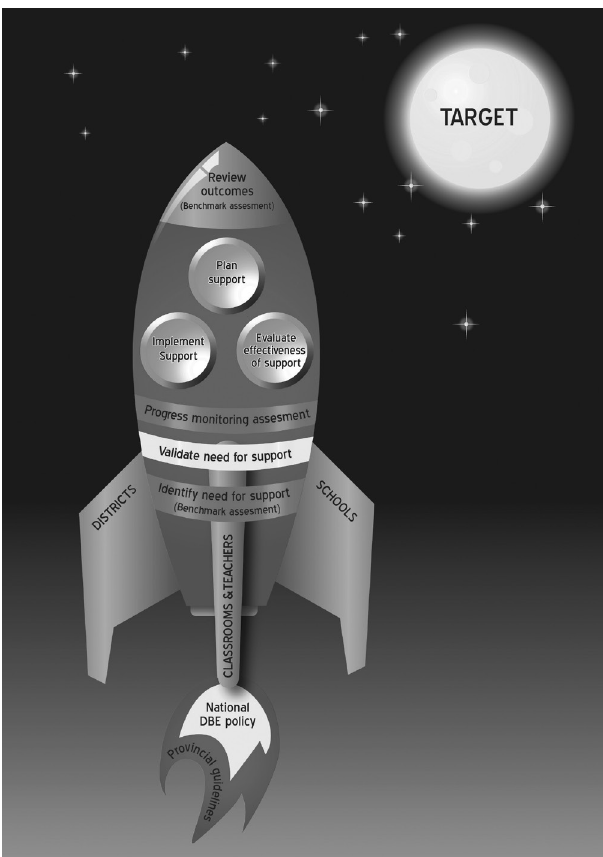
Figure 1: An assessment and support rocket